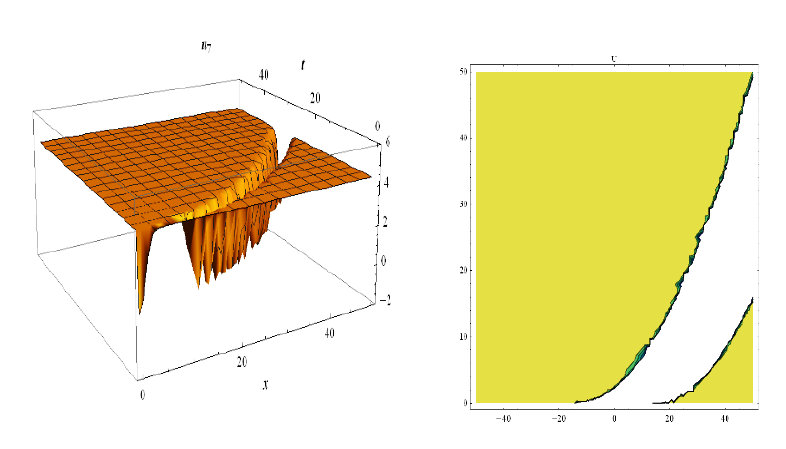
Figure 7. Three and two-dimensional surfaces of (22).